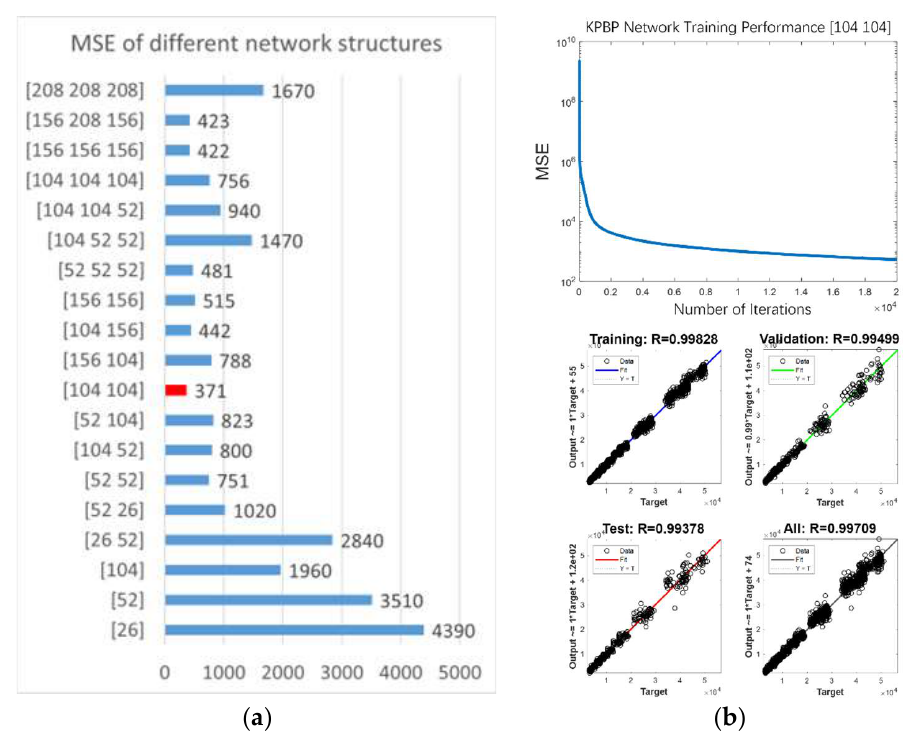
Figure 5. The KPBP network structure optimization result. ( a ) The final MSE of different network structures after 20,000 iterations. [104 104] was the best structure. ( b ) The training performance and the training evaluation of the best structure [104 104].